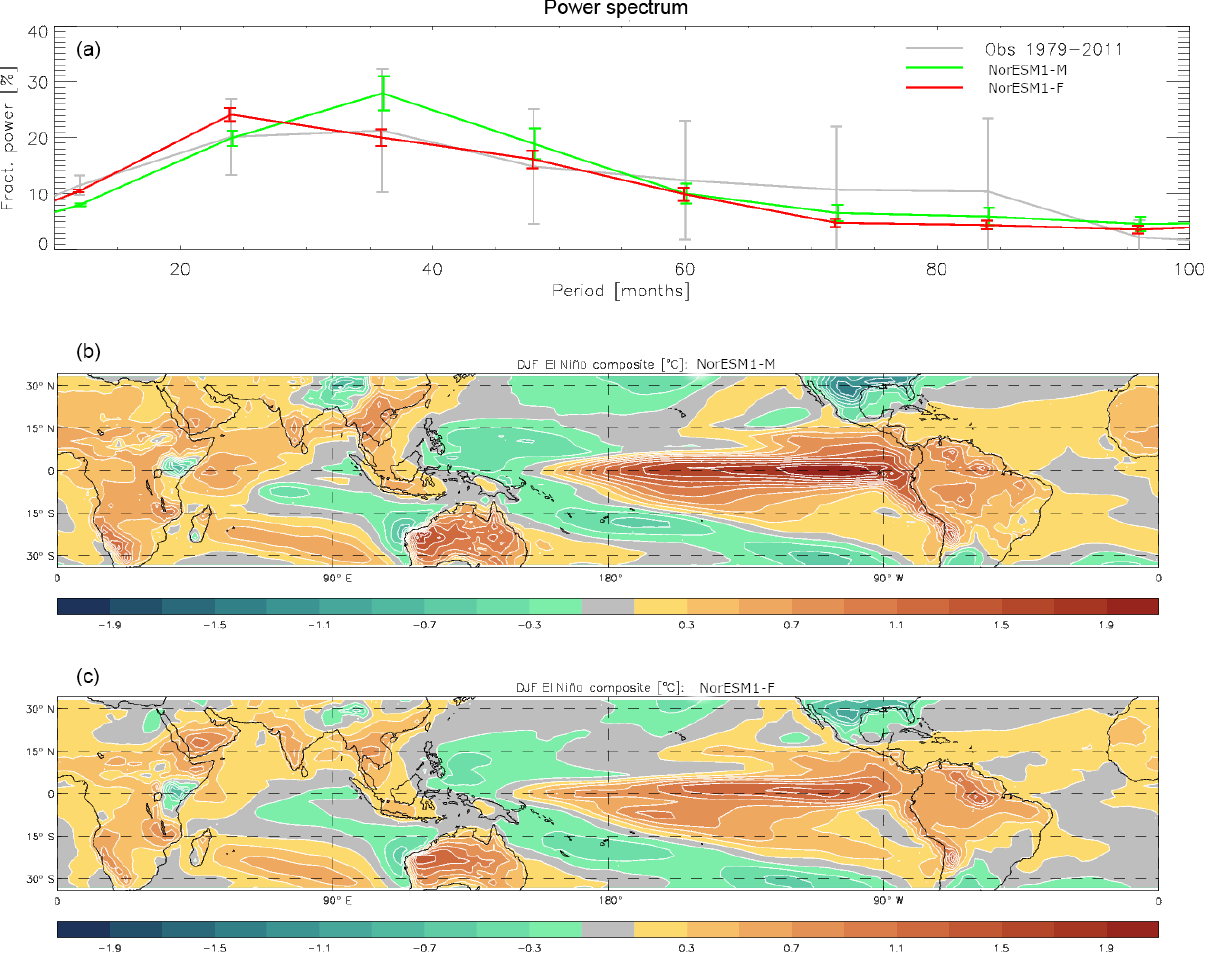
Figure 12. (a) Power spectra of the NINO3.4 index for the PI control experiments of NorESM1-F and NorESM1-M, with comparison to HadISST data. Composite DJF surface temperature anomalies during El Niño years for (b) NorESM1-M and (c) NorESM1-F. The data are from last 500 years of the PI control experiments for both